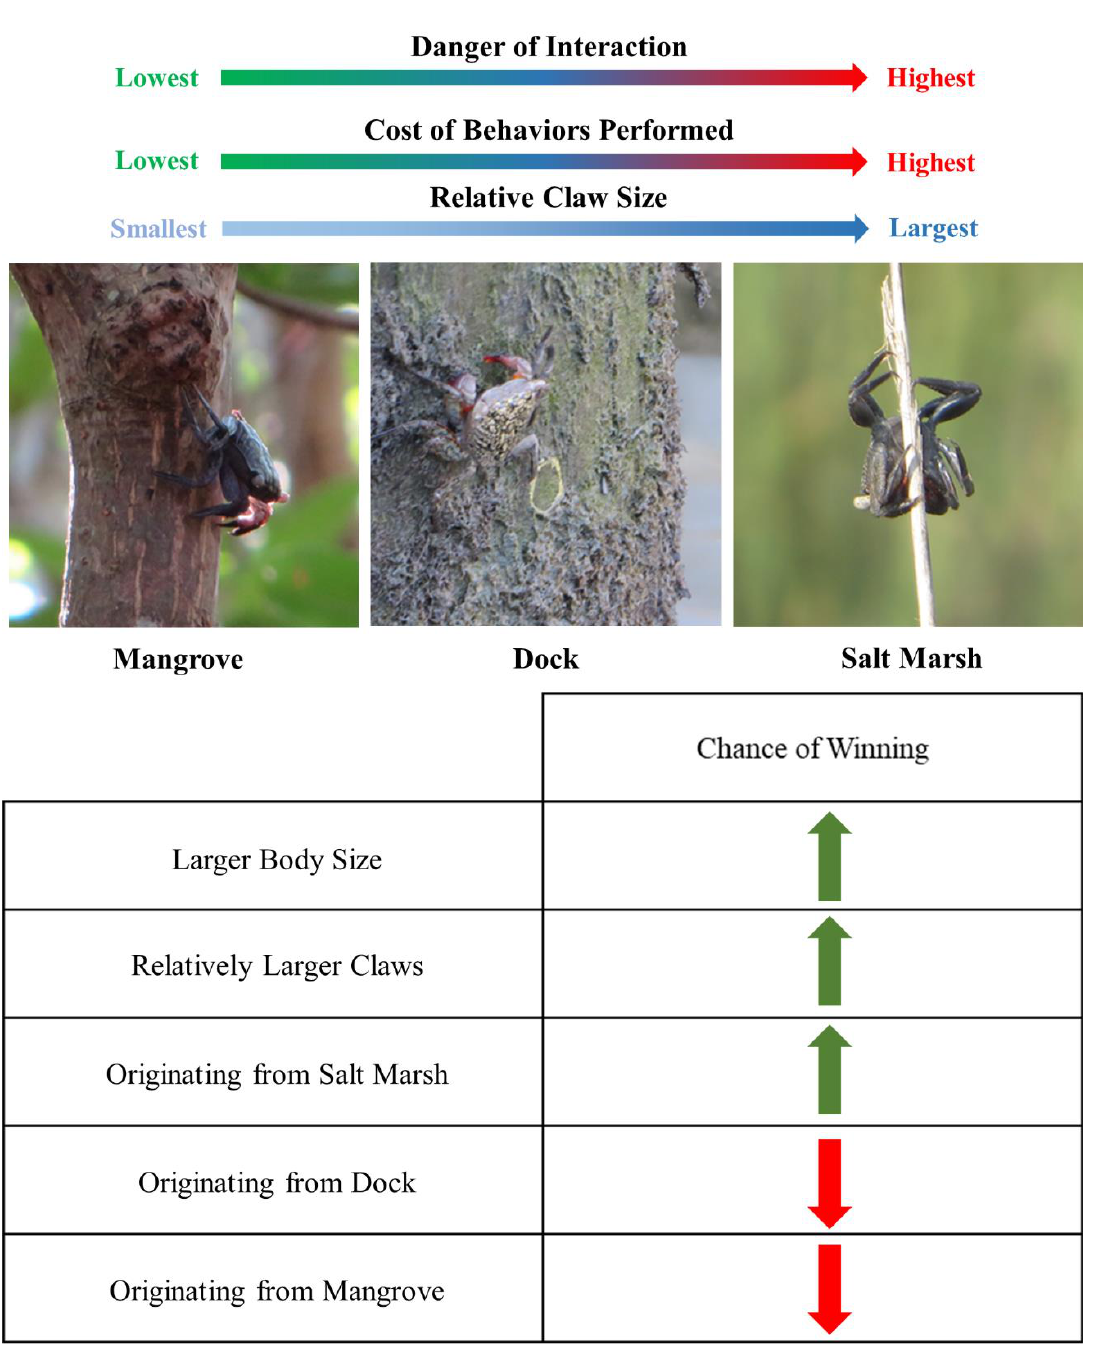
Figure 4. Summary of the effects of foundation structure and morphology on A. pisonii ritualistic aggression behavior. A green arrow indicates a higher chance of winning an interaction while a red arrow indicates a lower chance of winning.